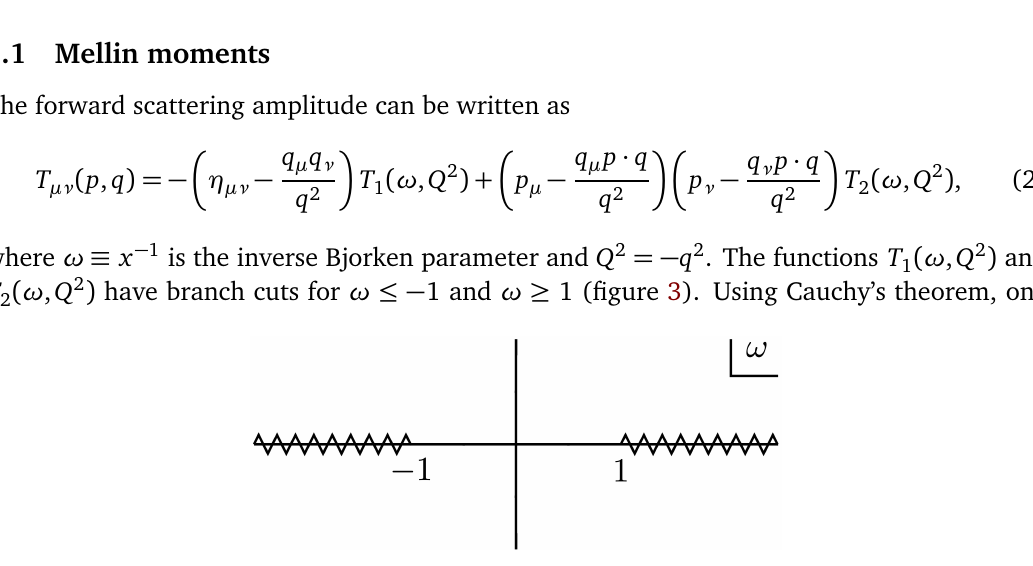
Figure 3: The functions T ω ≥ 1.